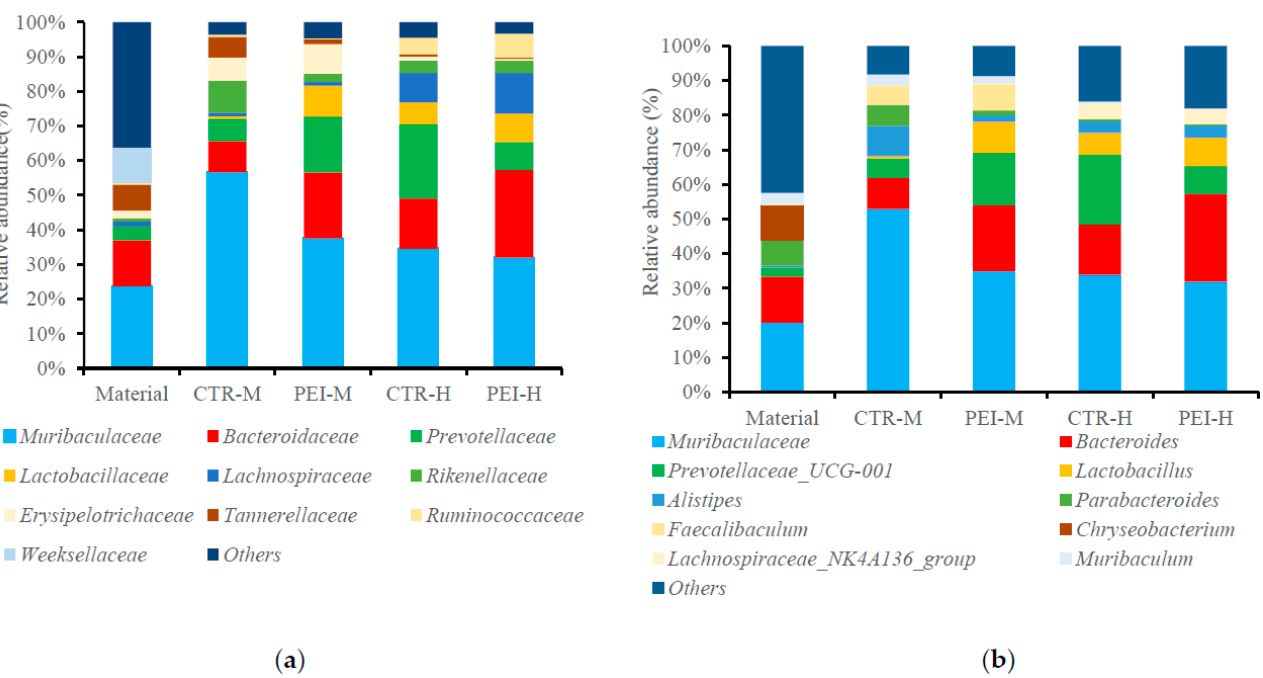
Figure 1. Relative abundances of the 10 most abundant family and genus of the bacterial microbiota of pre-ensiled crops and silages prepared from alfalfa silage. ( a ) Family- and ( b ) genus-level bacterial community in alfalfa silage. M—alfalfa ensiled at medium DM; H—alfalfa ensiled at high DM; CTR—no additive; PEI—inoculated with Land O’Lakes inoculant ( Pediococcus acidilactici , Enterococcus faecium and Lactobacillus plantarum ); M—medium DM alfalfa silage; and H—high DM alfalfa